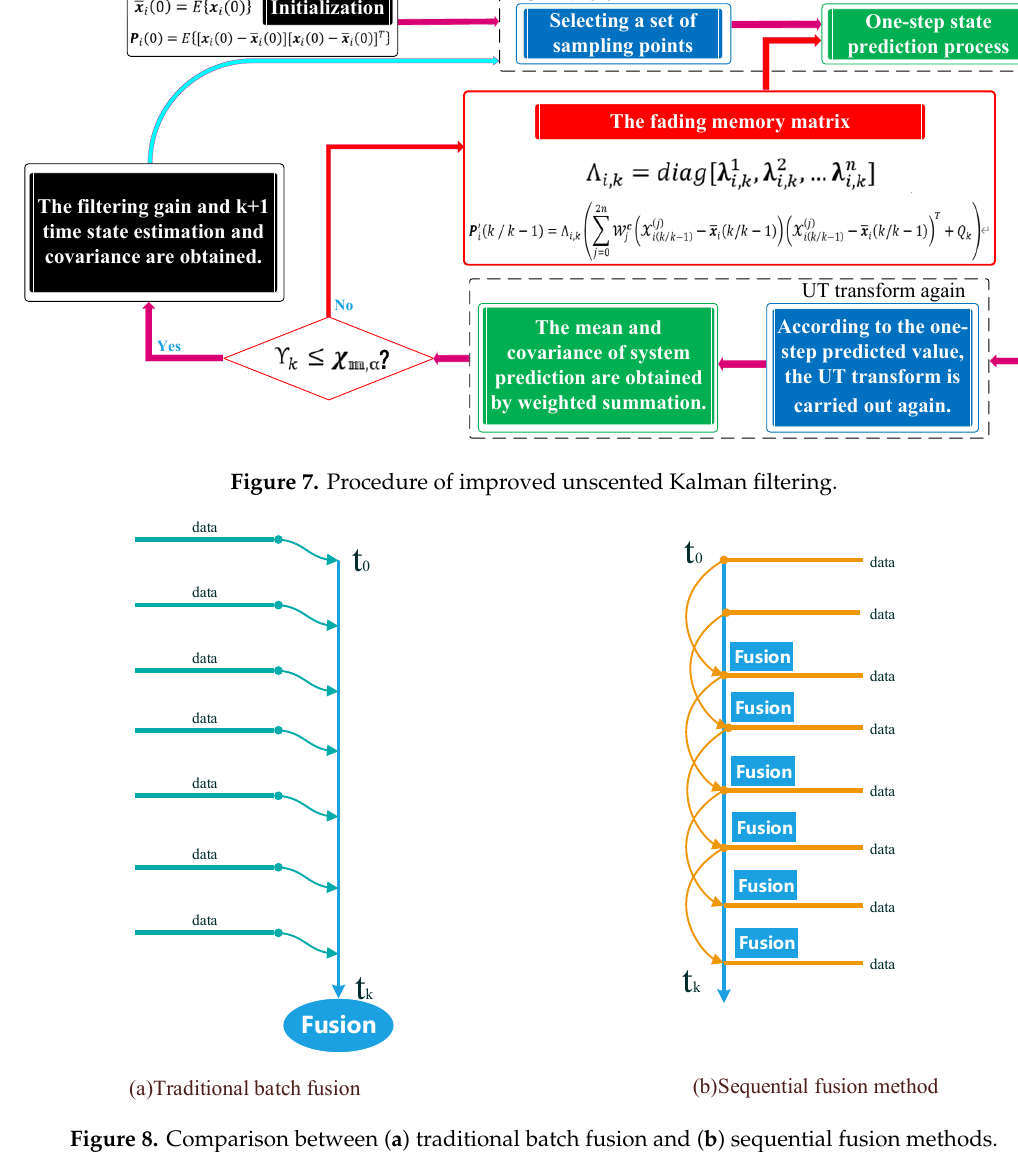
Figure 8. Comparison between ( a ) traditional batch fusion and ( b ) sequential fusion methods.